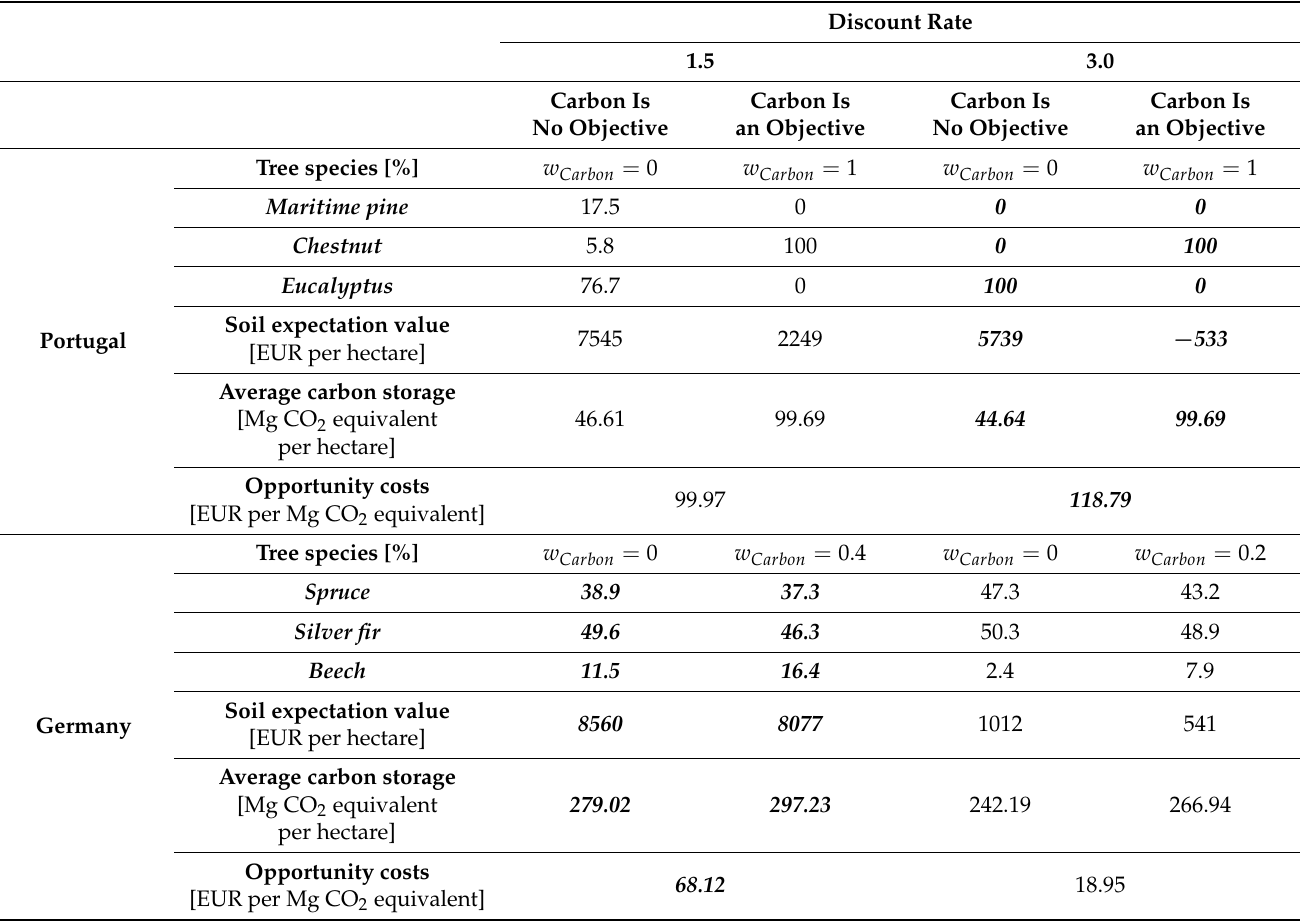
Table 2. Opportunity costs off additional carbon in forest stands in Portugal and Germany. Default discount rates 3.0% and 1.5% for Portugal and Germany, respectively (corresponding results in bold and italics).